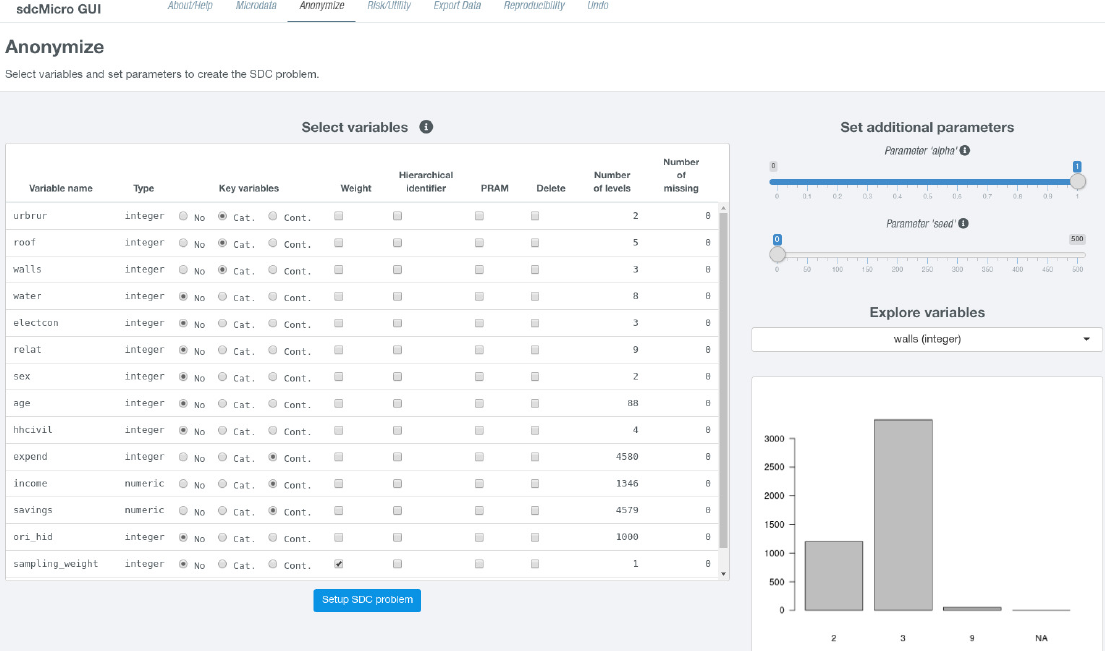
Figure 2. Defining a problem instance: on the left hand side important (key) variables can be defined, while a suitable graphic on the right hand side helps to identify suitable variables.